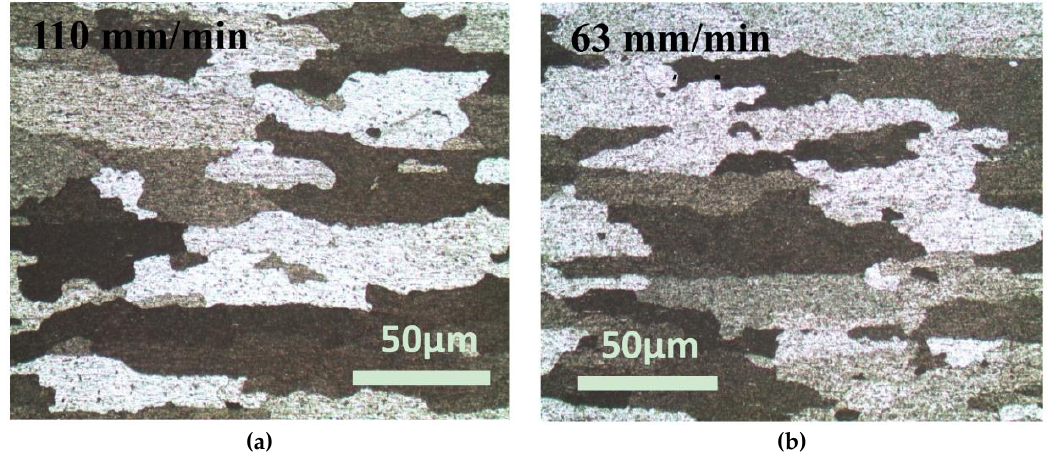
Figure 7. Optical images of Heat Affected Zones (HAZs) of different welding speed ( a ) 110 mm/min welding speed ( b ) 63 mm/min welding speed.